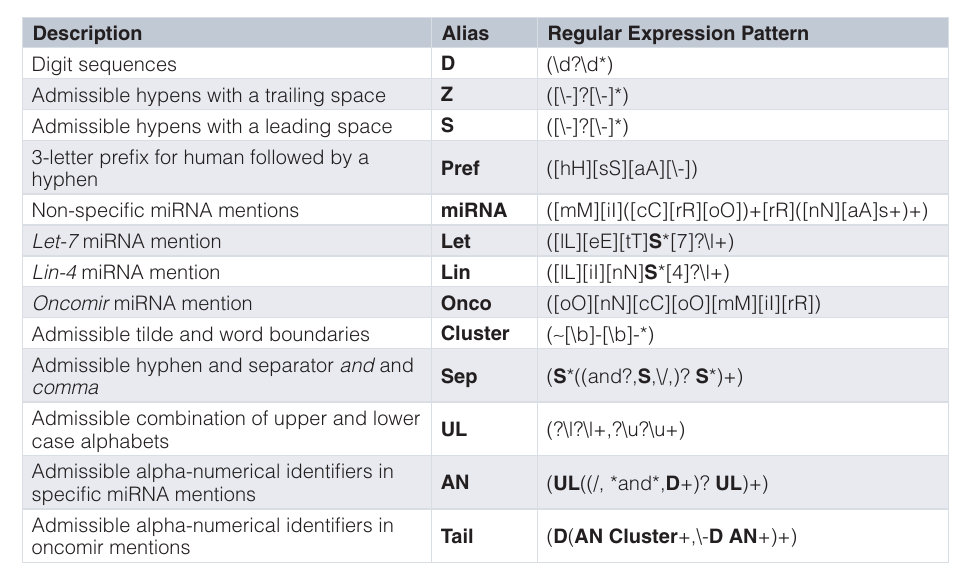
Table 5. MiRNAs regex aliases. Aliases used in regular expression patterns for miRNAs identification (highlighted in bold).